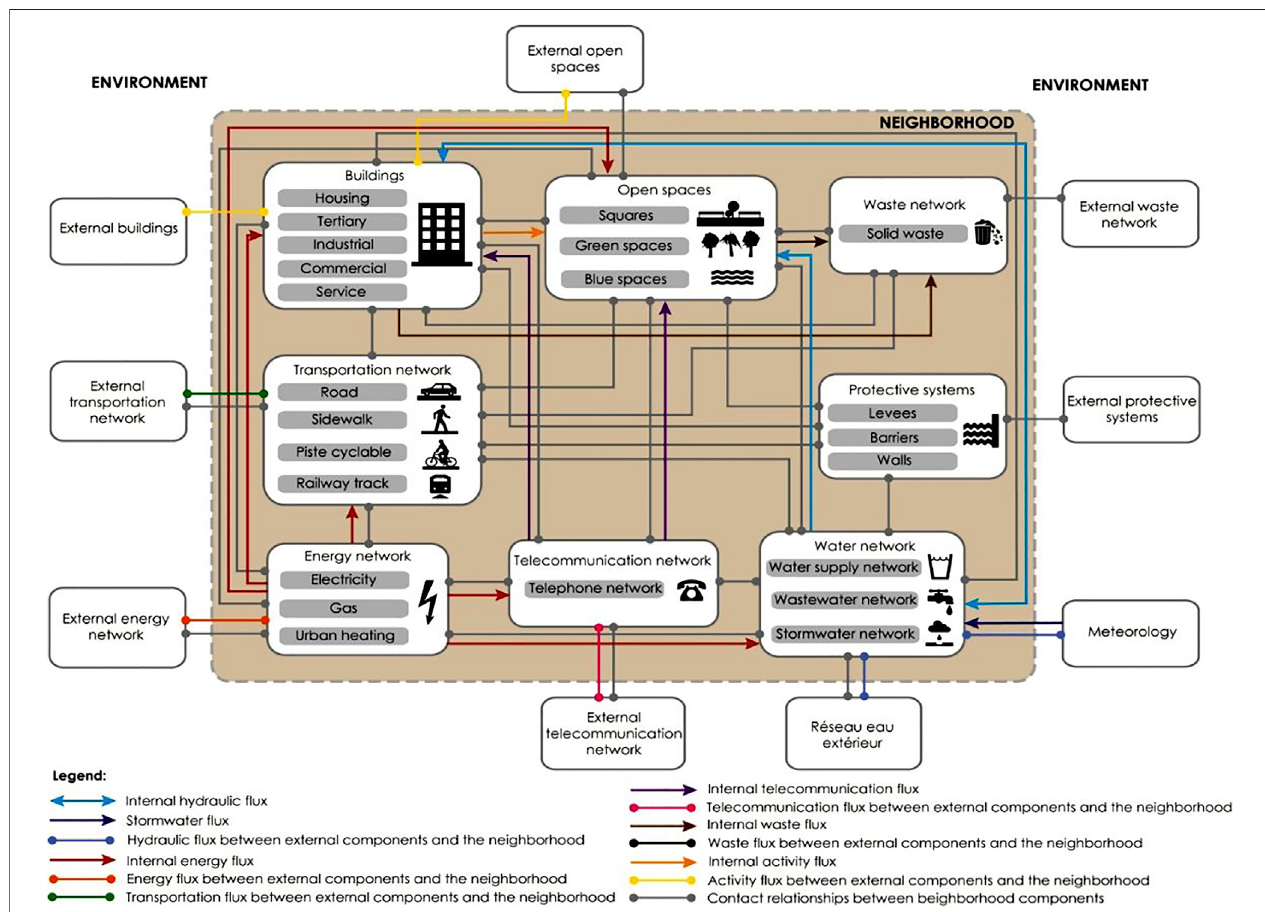
FIGURE 11 | Functional diagram of the neighbourhood system (Serre et al.,